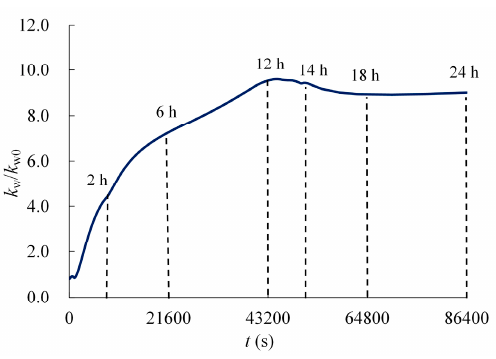
Figure 7. The change curves of the solution permeability ratio, k w / k w0 , with time, t.